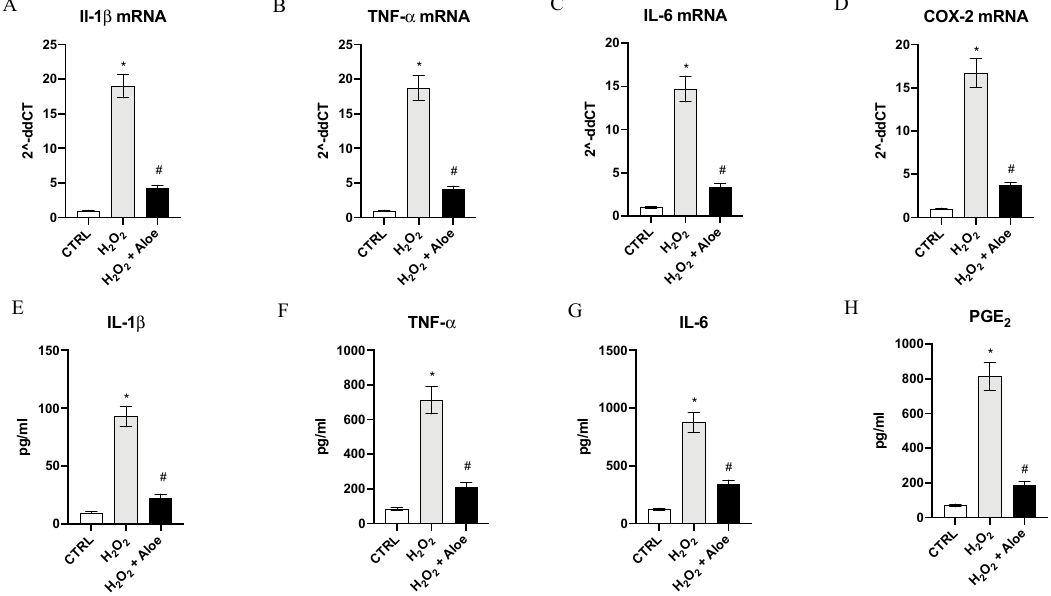
Figure 3. Effects of pre-treatment with aloe extract on IL-1 β ( A ), TNF- α ( B ), IL-6 ( C ), COX-2 ( D ) mRNA expression. Effects of pre-treatment with aloe extract on IL-1 β ( E ), TNF- α ( F ), IL-6 ( G ), PGE 2 ( H ) levels. Values are expressed as the means ± SD. * p < 0.0001 vs. CTRL; # p < 0.0001 vs. H 2 O 2 .